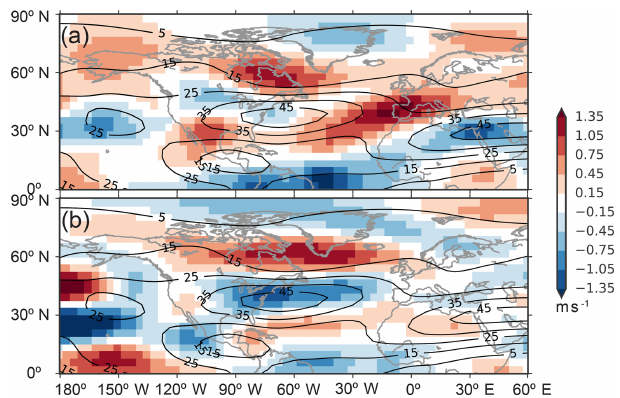
Figure 9. DJF 200hPa zonal wind speed anomalies compared to the pre-surge phase. Overlays show zonal wind speeds in the pre-surge phase in ms − 1 . Dashed lines mark negative values. (a) Surge phase, (b) post-surge phase. Note the projection with a focus on the North Atlantic. For a definition of the phases see Fig. 1 and Sect. 2.3.